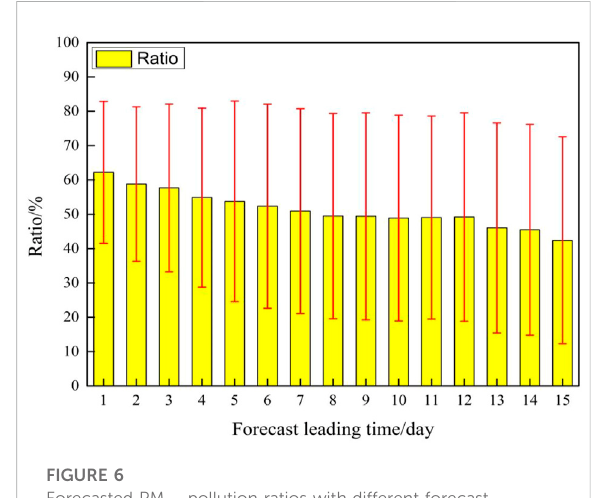
FIGURE 6 Forecasted PM 2.5 pollution ratios with different forecast leading